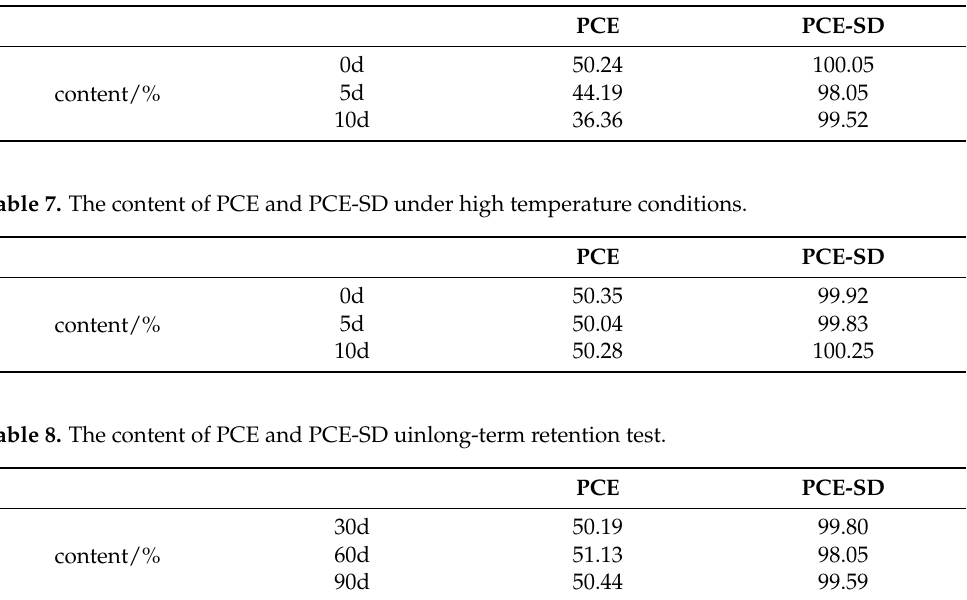
Table 6. The content of PCE and PCE-SD under strong light.